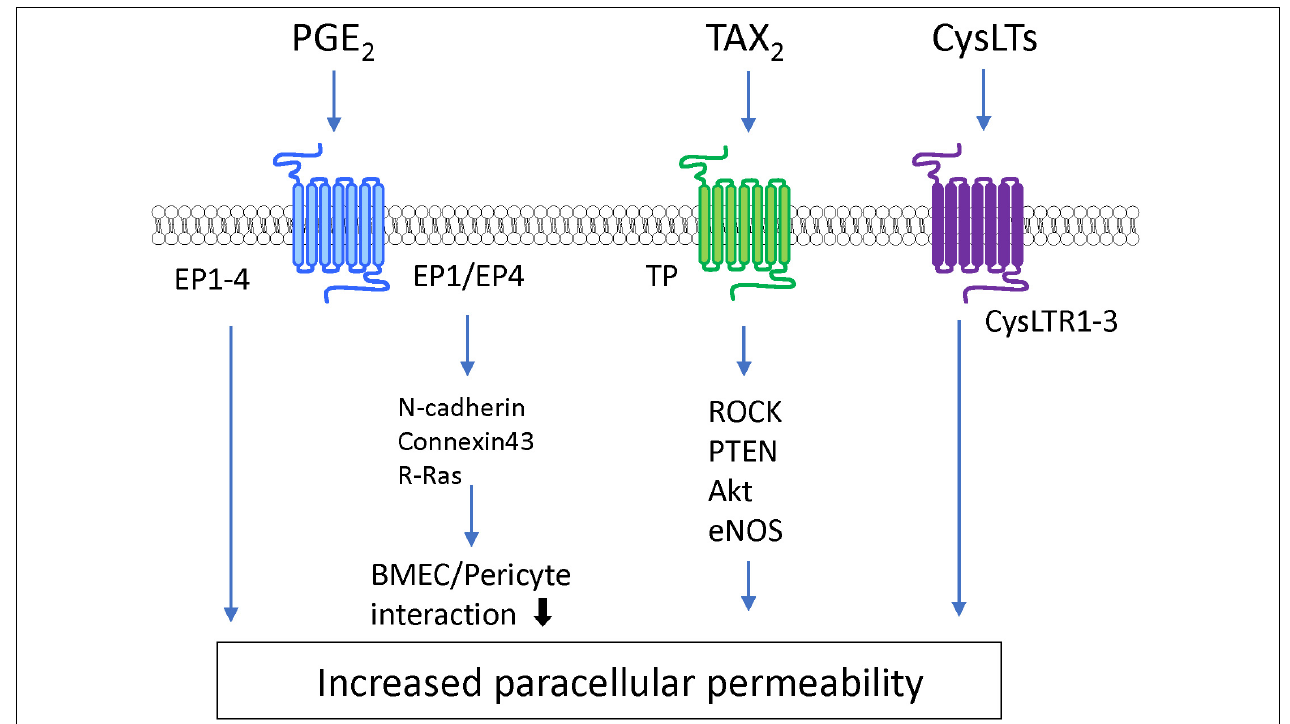
FIGURE 5 | Intracellular signaling pathways induced by eicosanoids in BMECs leading to BBB dysfunction.